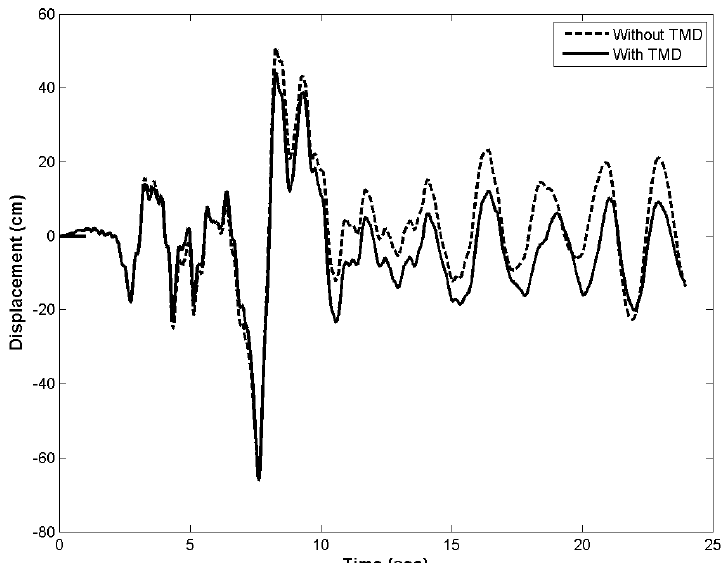
Fig. 7. Displacement Results for the Roof of a First Floor Irregular Structure Subjected to the Northridge Earthquake (PGA =